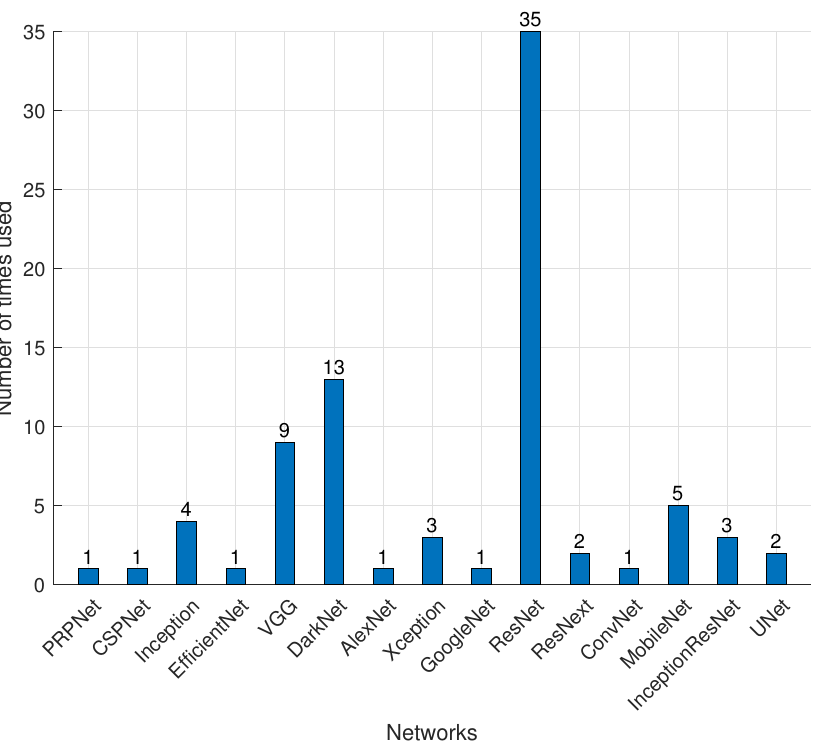
Figure 10. Distribution of different deep learning training networks used in controlled environment